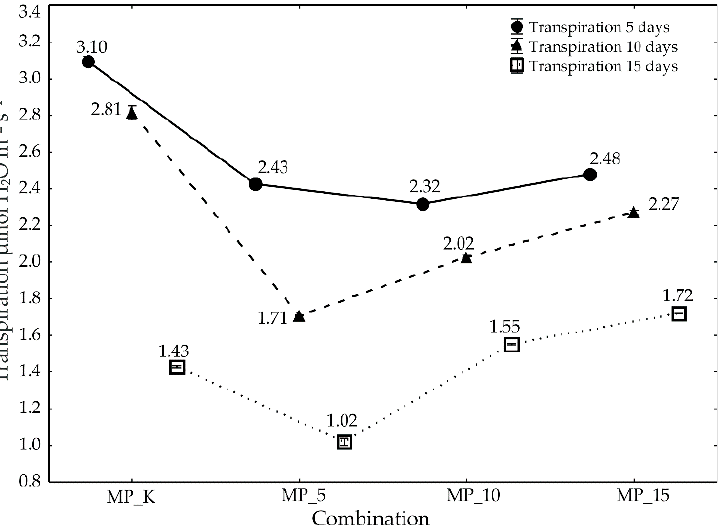
Figure 6. Intensity of transpiration in the set time intervals in oilseed rape with different numbers of foraging aphids of M. persicae . Vertical lines at mean values indicate SE.